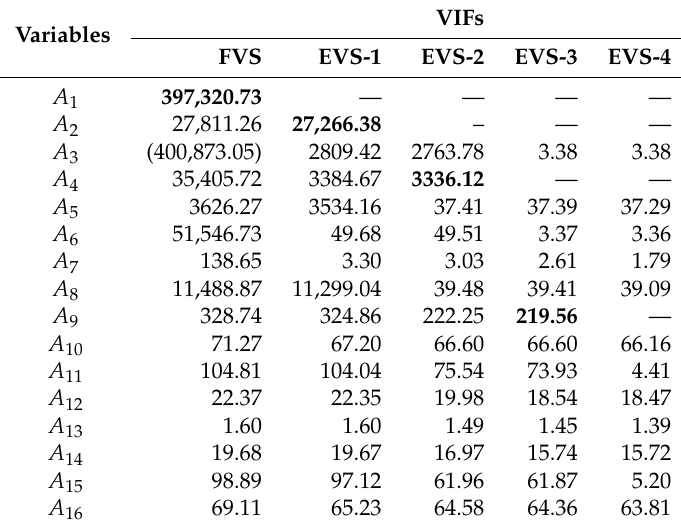
Table 4. Variance inflation factors (VIFs) in the east heading.